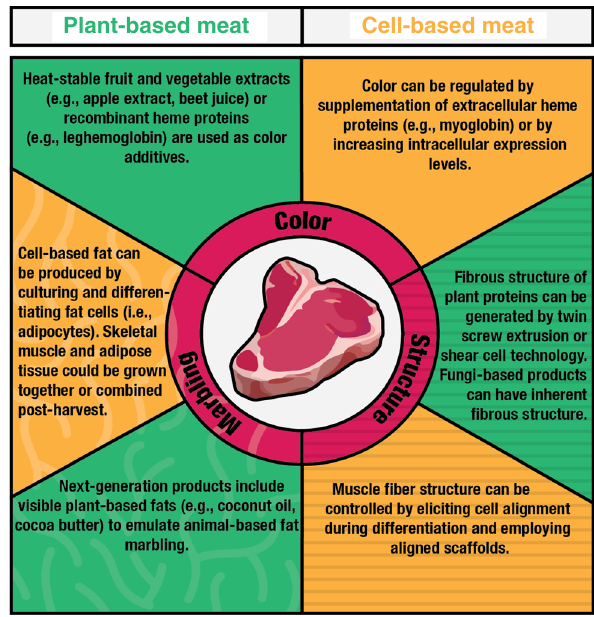
Fig. 3 Plant-based and cell-based strategies for emulating appearance properties (color, marbling, structure) of meat. Structure and marbling are signi fi cant contributors to the texture of meat as well as